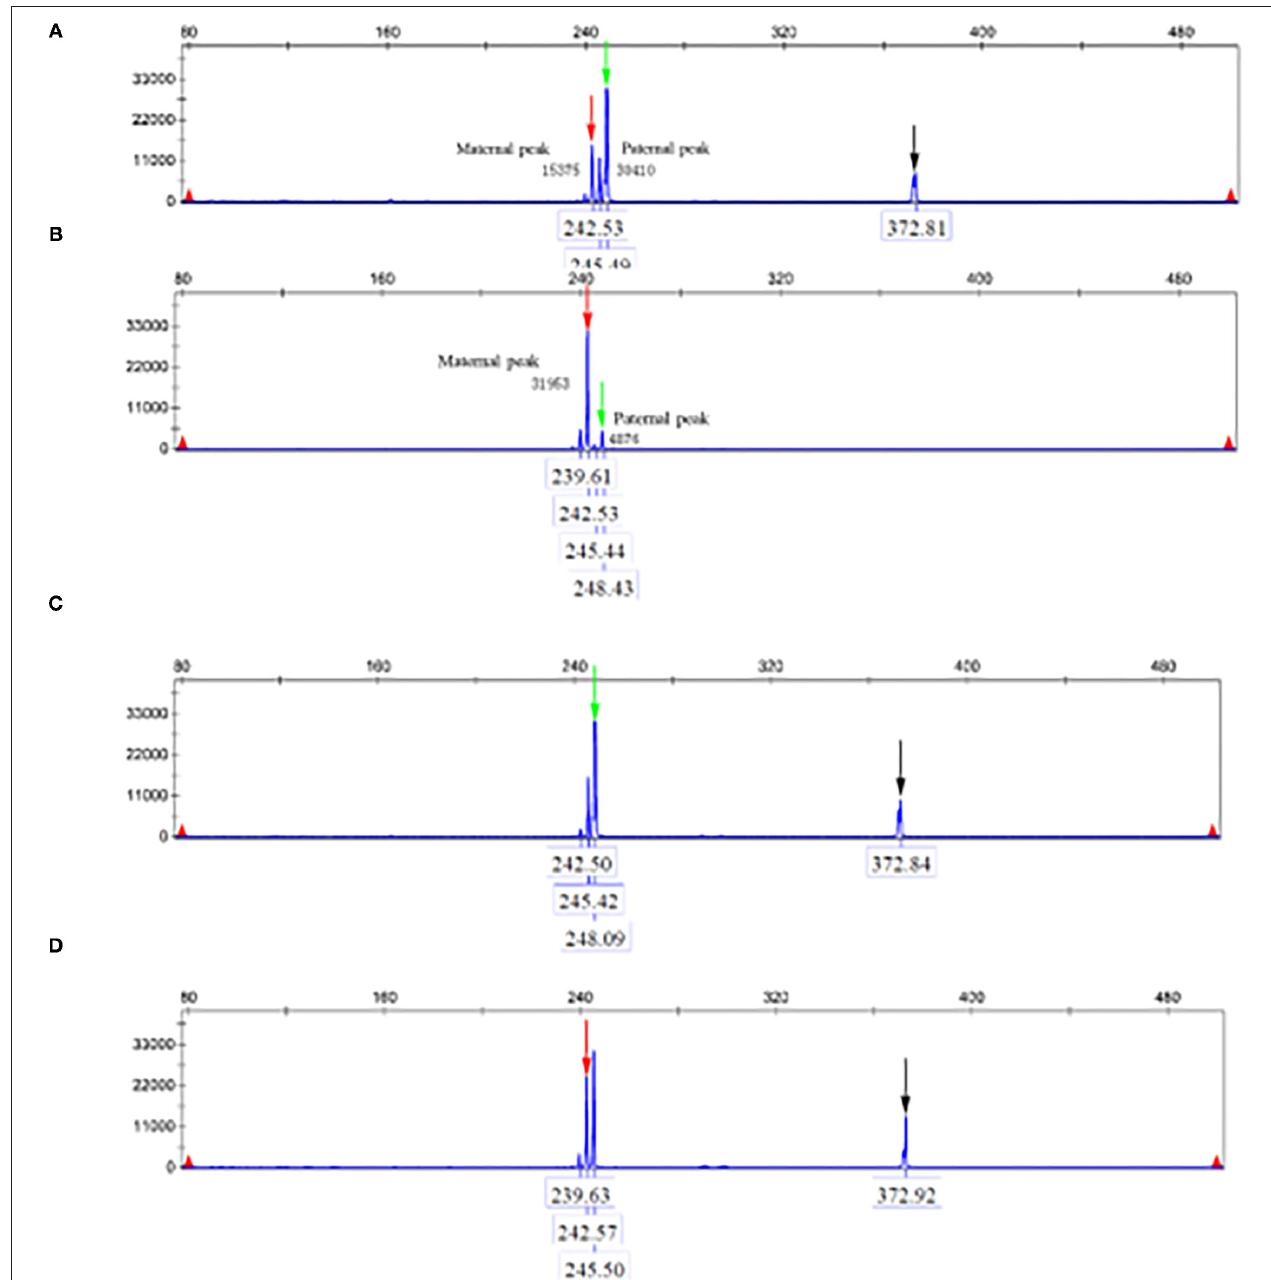
FIGURE 2 | (A) Indicate the amplification products of the reference gene and no amplification product after digestion. (B) PCR of proband’ s mother after digestion. Black arrows indicate the amplification products of the reference gene and no amplification product after digestion. (C) Paternal AR gene. (D) Maternal AR gene.